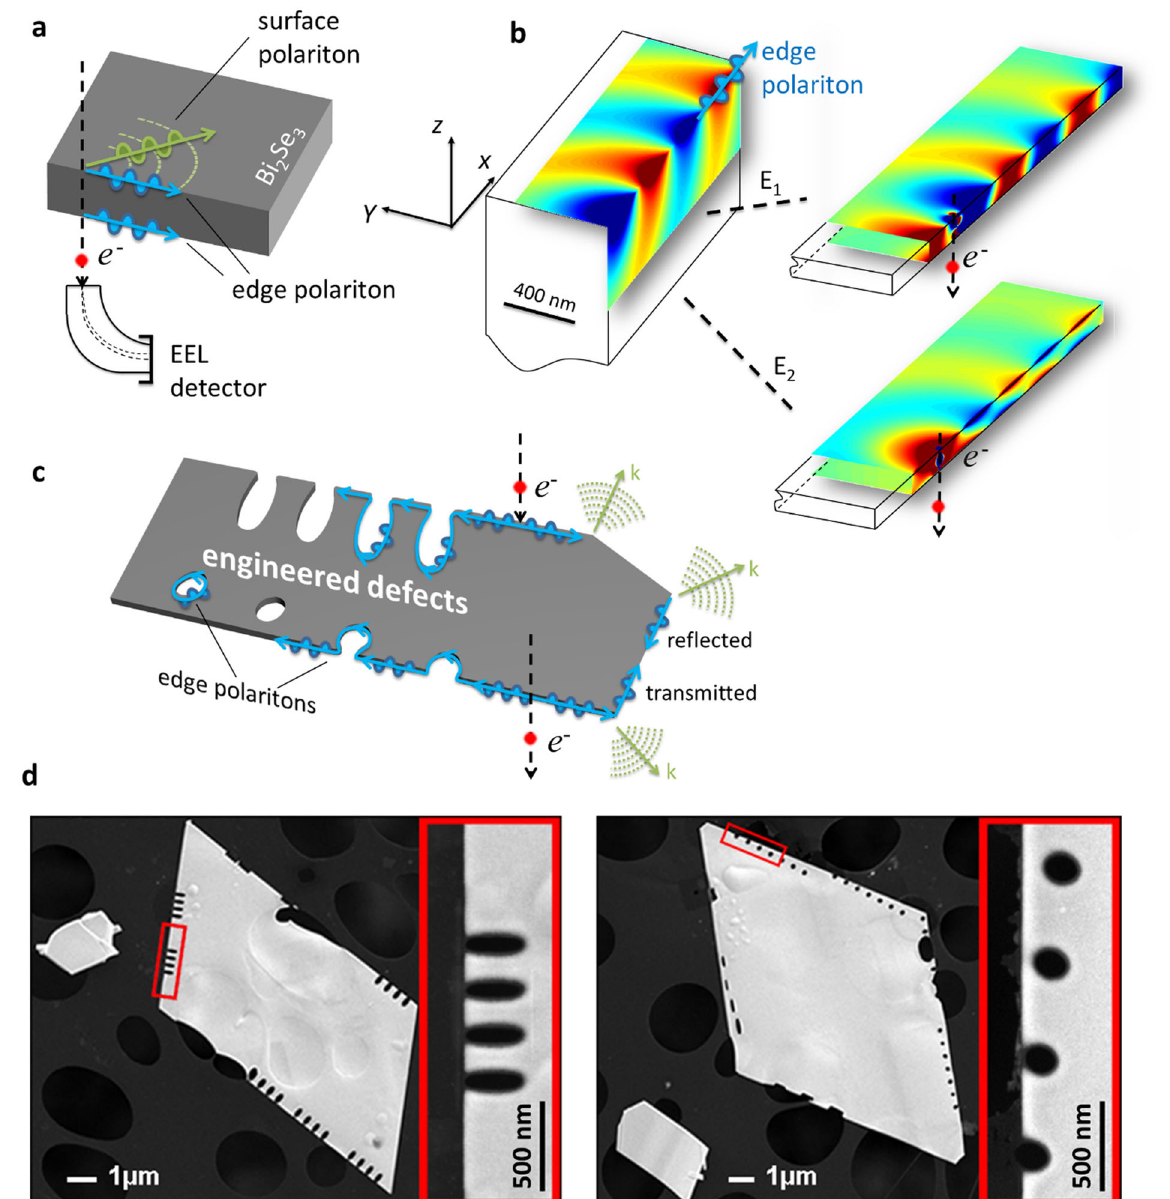
Fig. 1 Excitation of polaritons in Bi 2 Se 3 by electron beams. a During the inelastic interaction of fast electrons with the specimen, both surface polaritons and edge polaritons are excited, and consequently the electrons experience energy-losses. The electron energy-loss spectrum is then acquired by the energy-dispersive detection system. b z -component of the electric fi eld associated with edge polatitons propagating along the edges of a Bi 2 Se 3 large cube, at the energy of 4 eV. The edge modes are hybridized in thin fi lms to form symmetric and antisymmetric modes. Here, E 1 ¼ 4 : 3 eV, and E 2 ¼ 3 : 8 eV, and the thickness of the fi lm is 60 nm. Red and blue colors represent positive and negative values, respectively. c The interaction of hyperbolic edge polaritons at corners and with precisely engineered scatterers of different topology causes re fl ection, transmission, and radiation of partial waves. d SEM images of the investigated structures. The HEEPs at the upper and lower edge of the nanoplatelets hybridize into a symmetric and an anti-symmetric mode, very similar to surface polaritons in thin fi